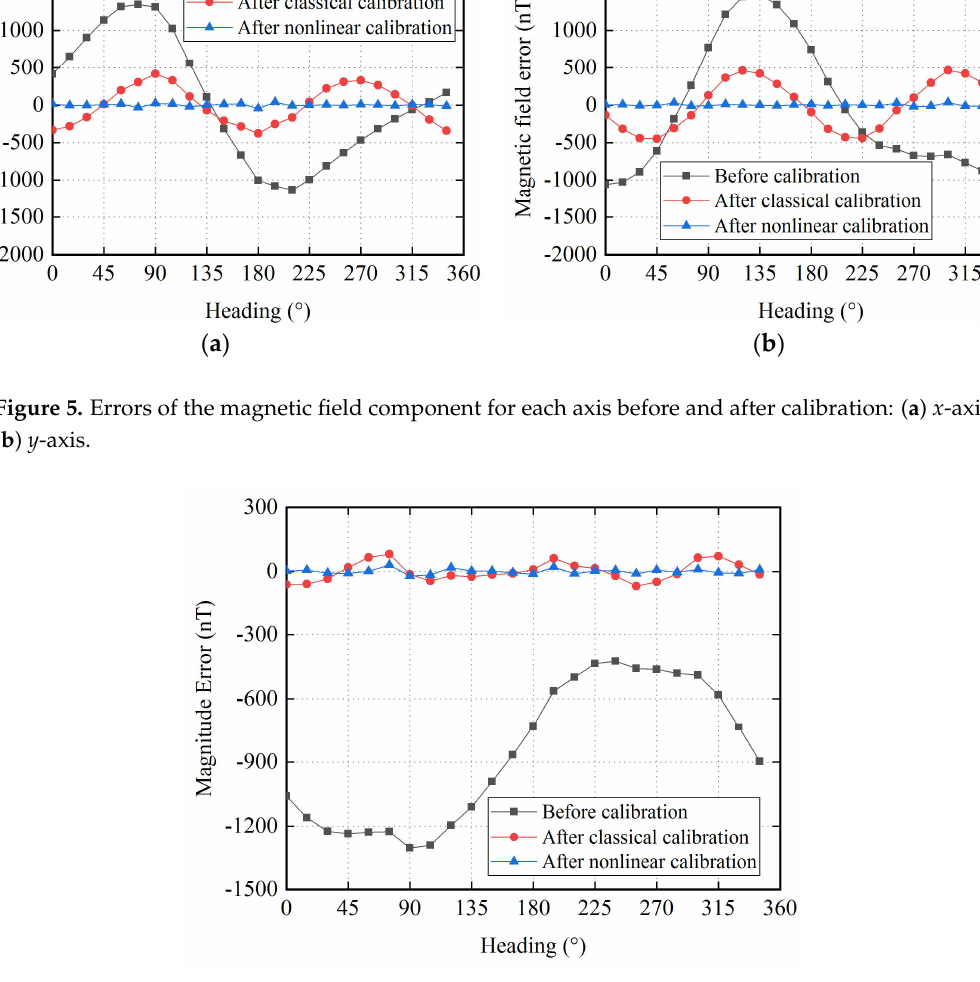
Figure 6. Errors of the magnetic field magnitude before and after calibration.